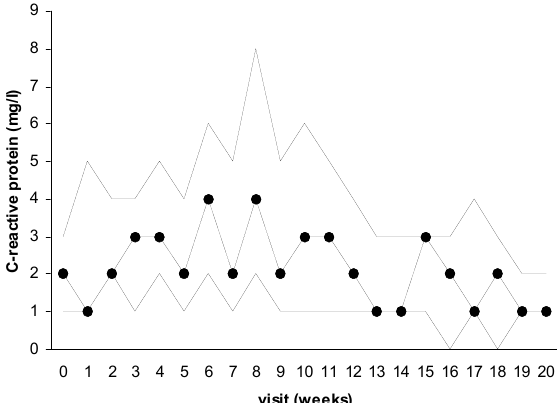
Figure 3. Serum C-reactive protein during dose-dense chemotherapy. Shown are the medians of serum C- reactive protein concentrations obtained in weekly intervals during the chemotherapy with 95 % confi- dence intervals indicated by the dashed line. Serum C- reactive protein was significantly increased compared to baseline only at visits (weeks) 4, 6 and 8. n e